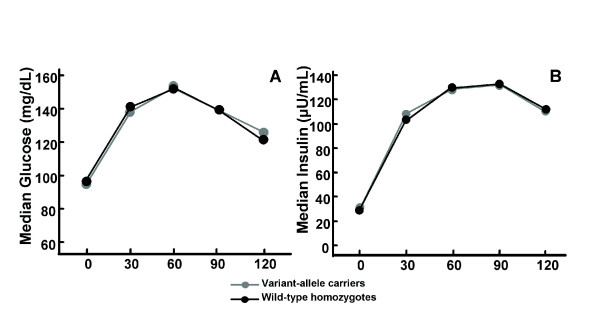
Carriers of APOC3 variant alleles (-482T, -455C or both) were compared with homozygous for the wild-type alleles at both SNPs (-482C and -455T alleles) for glucose and insulin measurements during oral glucose tolerance test (OGTT). The study cohort underwent OGTT (75 g) test and glucose and insulin were measured baseline (0) and at 30, 60, 90 and 120 min after the administration of glucose. (A) Median glucose and (B) insulin in individuals stratified by the genotypes. No statistical differences were found in either insulin or glucose at different time points in the two groups. P-values were calculated by linear regression (all P-values = NS), including age, gender and body mass index (BMI) as covariates in the model.